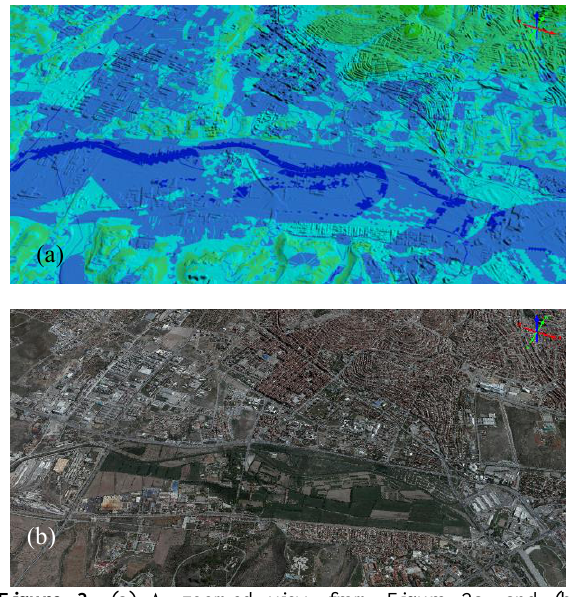
Figure 3. (a) A zoomed view from Figure 2a; and (b) corresponding